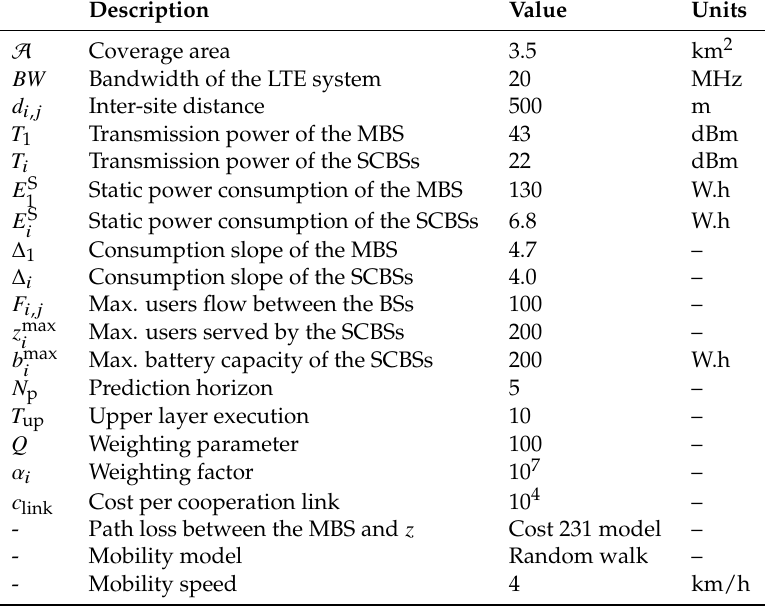
Table 1. Summary of the main